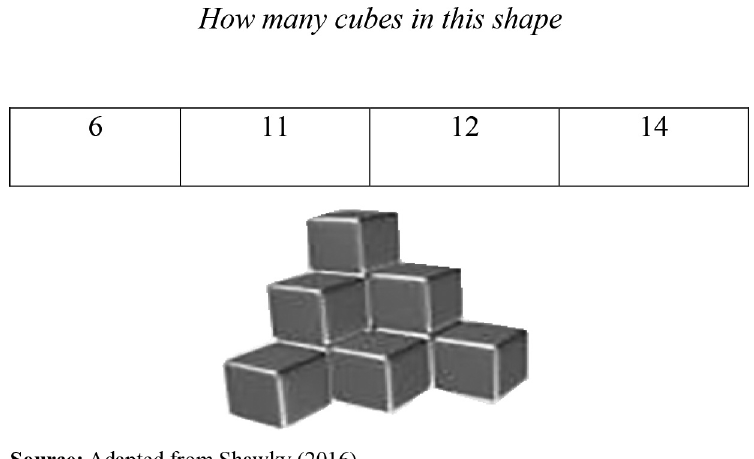
Figure 7. Example of Spatial